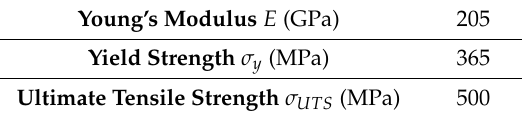
Figure 4. Stress and strain responses under monotonic tensile loading. Table 2. Mechanical parameters of welded joint.